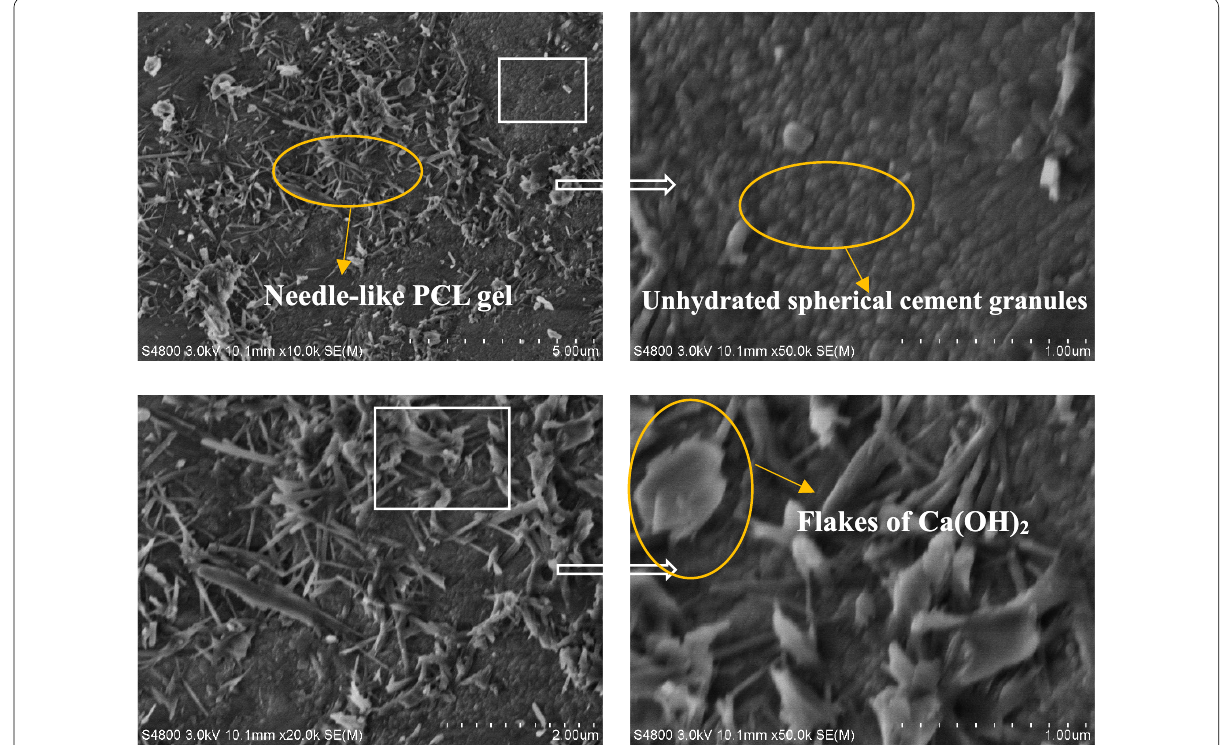
Fig. 19 SEM image of PCL‑cement mortar cross section (PCL